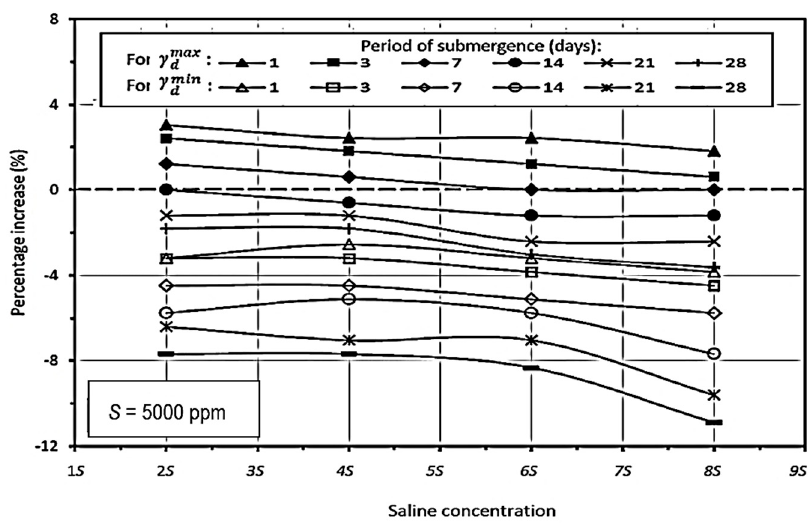
Figure 9. Variation of normalized dry density with saline concentration.